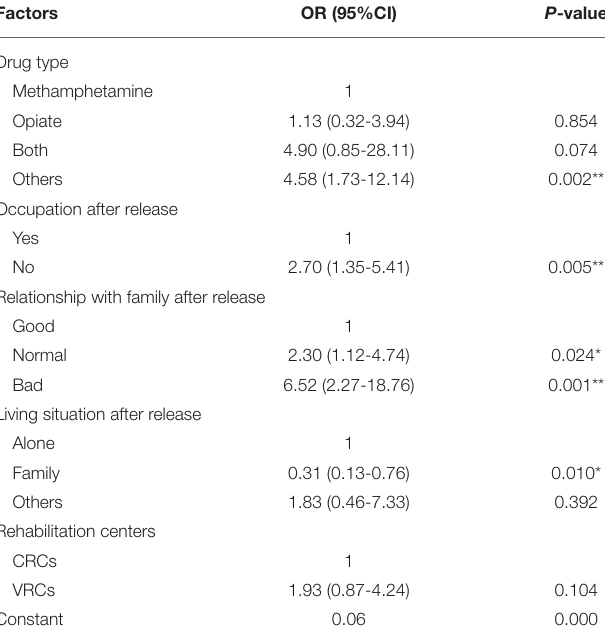
TABLE 5 | Binary Logistic regression analysis of factors to CRCs ( n = 439).